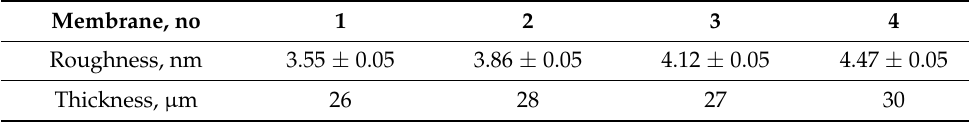
Table 2. Average thickness and roughness of